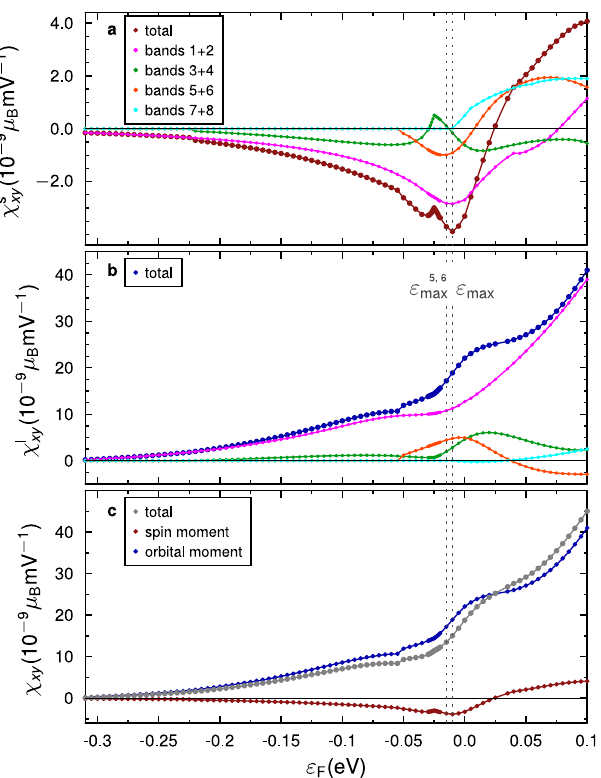
Fig. 3 | Edelstein effect. Edelstein conversion ef fi ciency χ xy representing the magneticmomentpersurfaceunitcellalong x directioninducedbyanelectric fi eld in y direction. a Contributionfromthespinmoments(red)andcontributionofeach band pair (colors as in Fig. 1). ϵ max corresponds to the energy where the total spin Edelsteinef fi ciencyismaximum, ϵ 5,6 max istheenergyofthethirdbandpair ’ s(orange) maximum of the Edelstein ef fi ciency. b Contribution from the orbital moments (blue) and contribution of each band pair. c Total Edelstein ef fi ciency